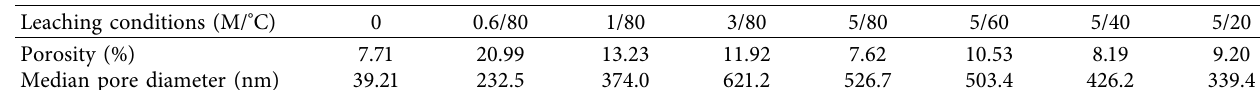
Figure 3: The distribution curves of pore diameter of cement waste forms after leaching under simultaneous effect: (a) the NH concentration is from 0 to 5 M while the temperature is 20 ° C; (b) the temperature is from 20 to 80 ° C while the NH 4 Cl concentration is Table 3: The characteristics of pore structure of cement waste forms.